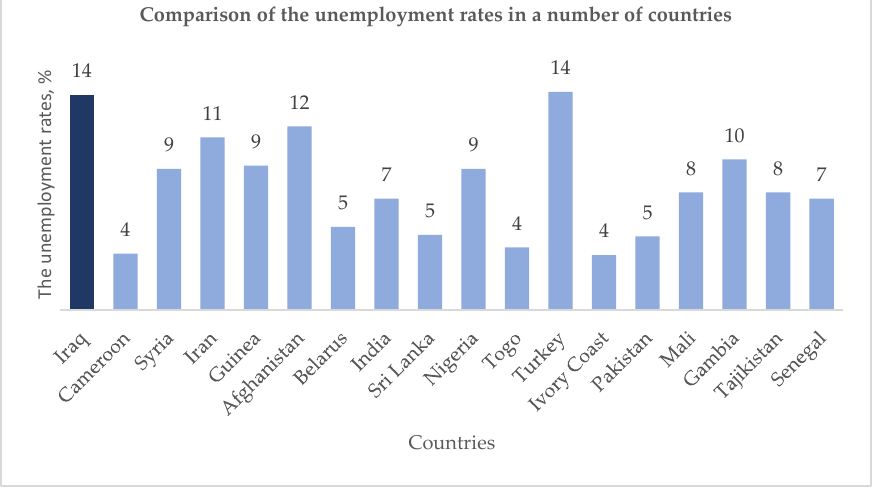
Figure 9. Comparison of the unemployment rates in a number of countries, % [5]. According to the World Bank, in 2020, the unemployment rate (as a percentage of the total population) in Iraq was 13.7%. For comparison, in Sweden, this figure was 8.4%, 4.3% in Germany, and 8.2% in the Euro area.